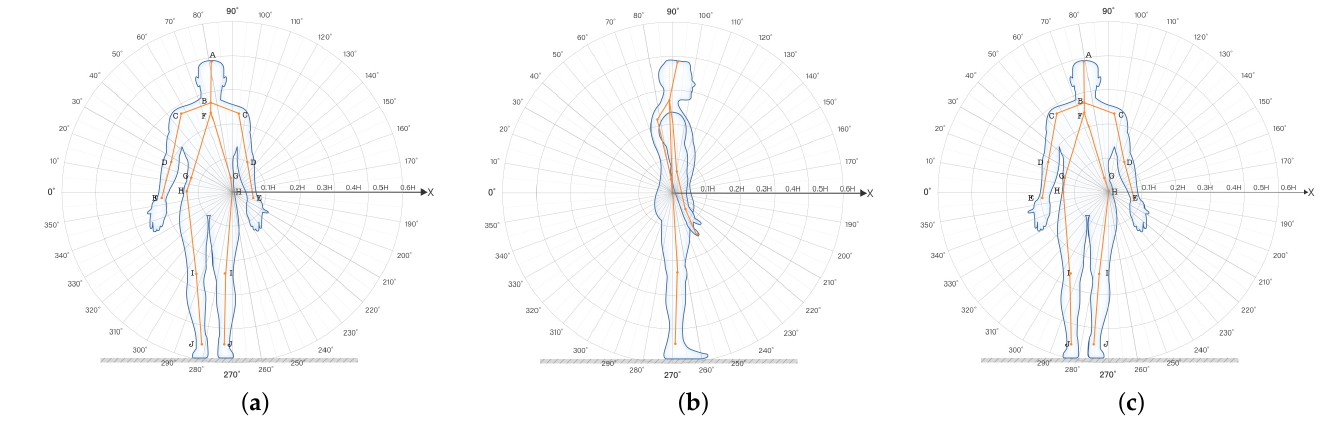
Figure 11. Human body diagram. The body-related angles are measured from three angles: front, back, and side. ( a ) Front view of anthropometry. ( b ) Side view of anthropometry. ( c ) Back view of